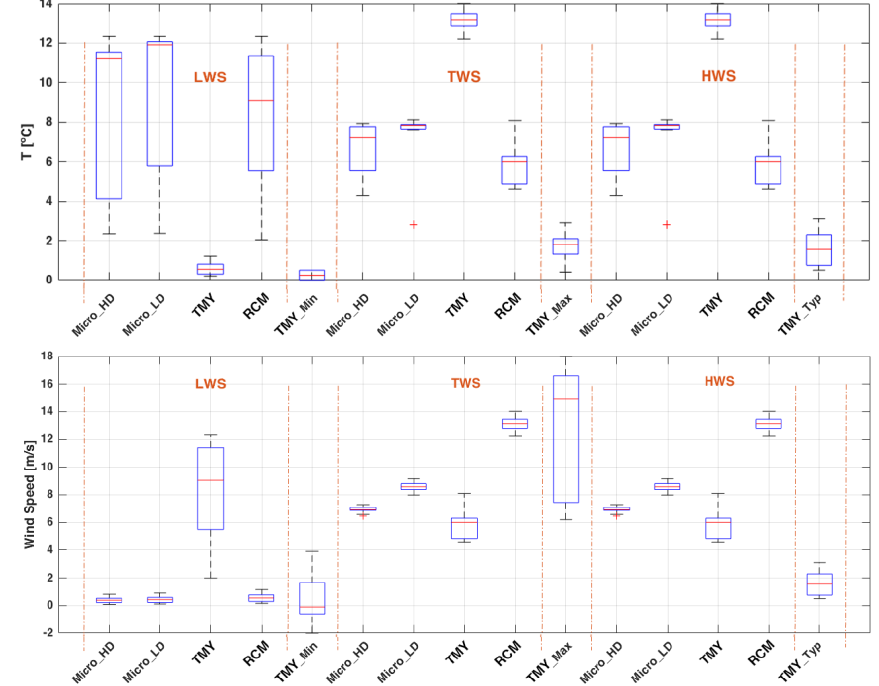
Figure 6. Boxplot of air temperature (up) and wind speed (down) out of Micro, RCM, and TMY data. TWS: 19 February; LWS: 4 October, HWS: 15 January; TMY-Typ: 14 September; TMY-Min: 17 November, and TMY-Max: 13 January. HD: High density; LD: Low density.